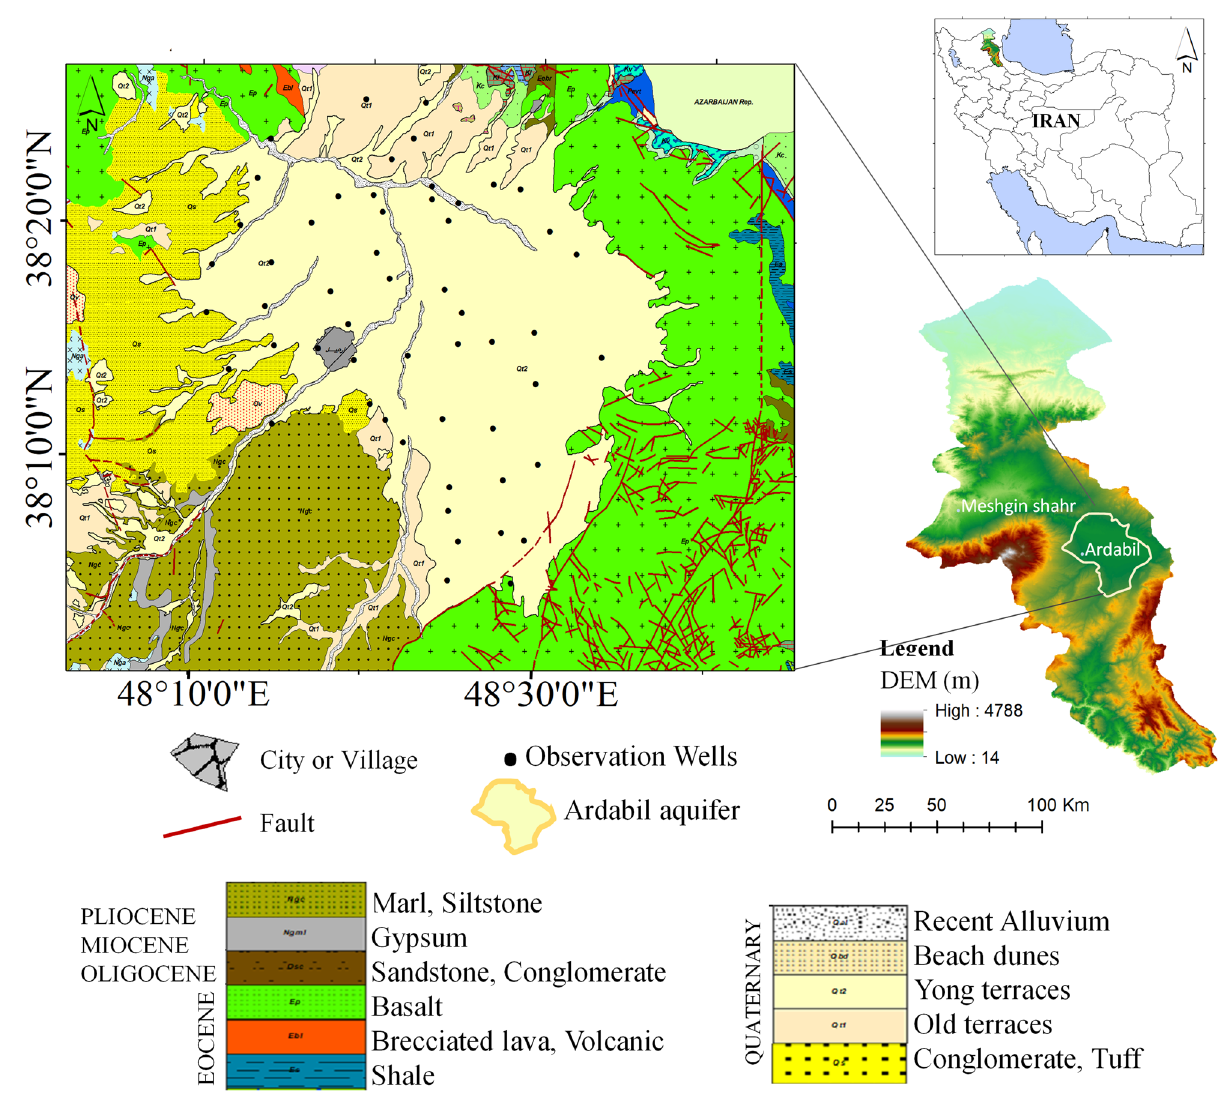
Figure 1. The geographical location of Ardabil plain. This figure was created using the QGIS version 3.14.0-Pi software (https:// qgis. org/ en/